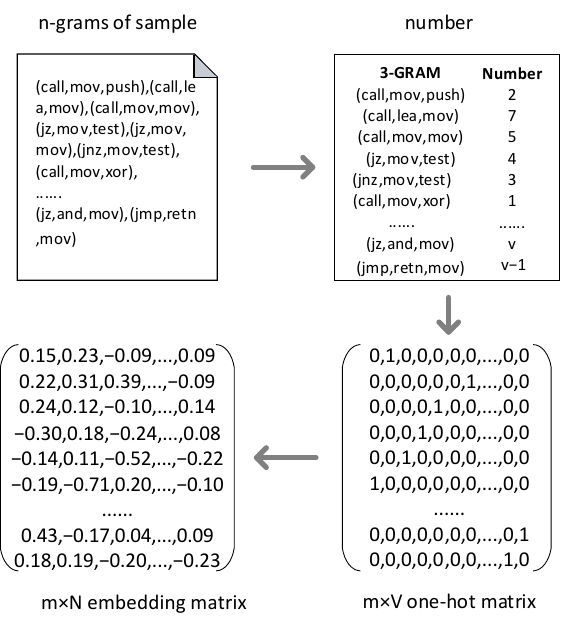
Figure 3. The feature embedding process. The formula of the embedding layer is as follows: H